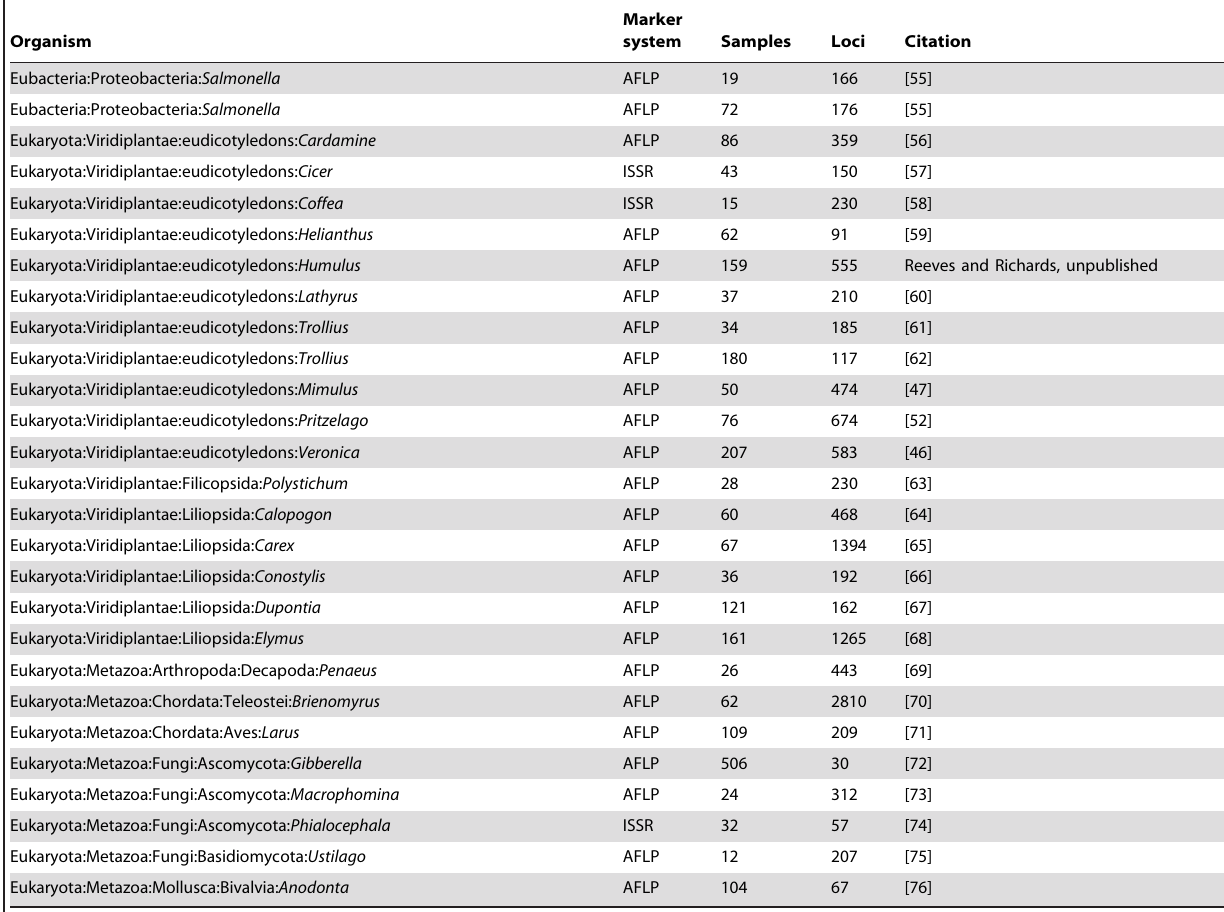
Table 1. Real data sets